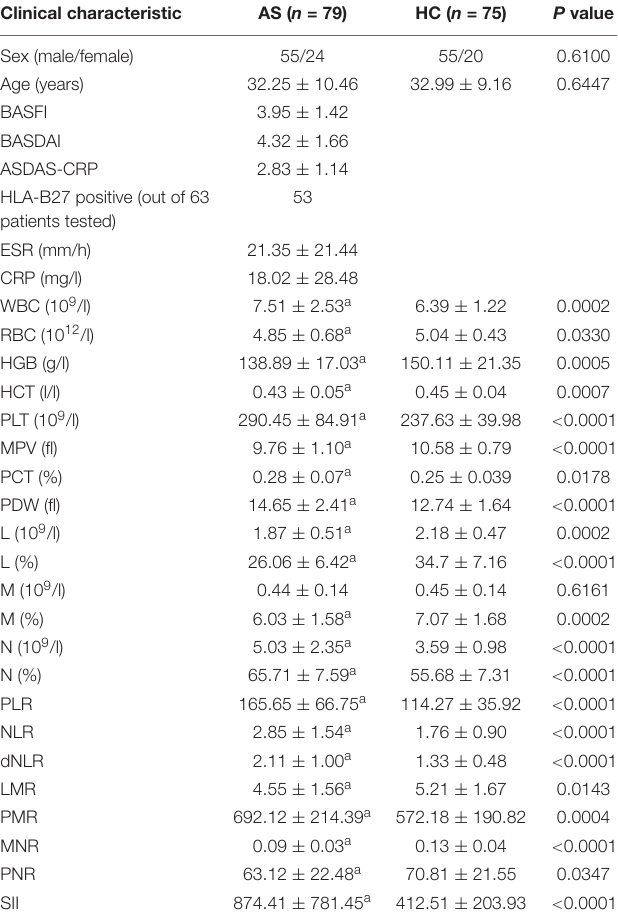
TABLE 2 | Clinical details of subjects with patients with new-onset AS and